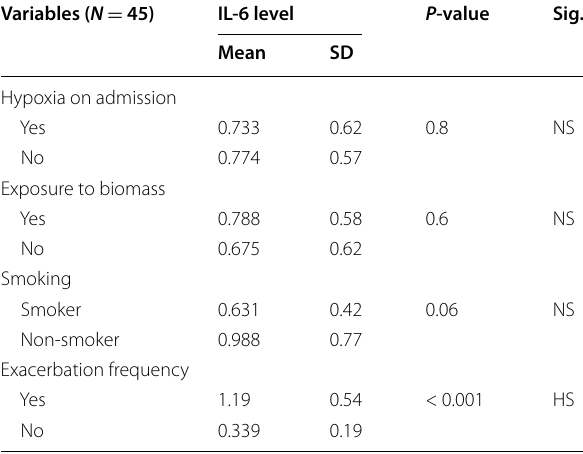
Table 3 Comparisons of IL‑6 level in different medical history among cases with